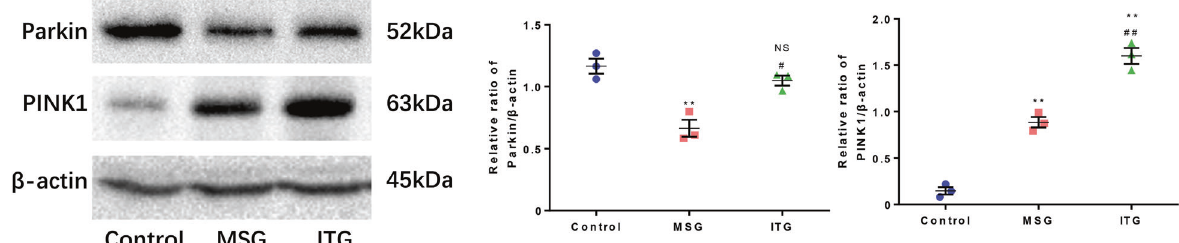
Fig. 4 Idebenone activates the mitochondrial autophagy Parkin/PINK1 pathway. a Protein immunoblotting of the Parkin and PINK1 levels in the mouse midbrain substantia nigra. b Statistics of Parkin protein levels in the substantia nigra of the mice. c Statistical analysis of the PINK1 protein level in the mouse midbrain substantia nigra ** P < 0.01, NS not signi fi cant vs. control, # P < 0.05, ## P < 0.01 vs. MSG, N =